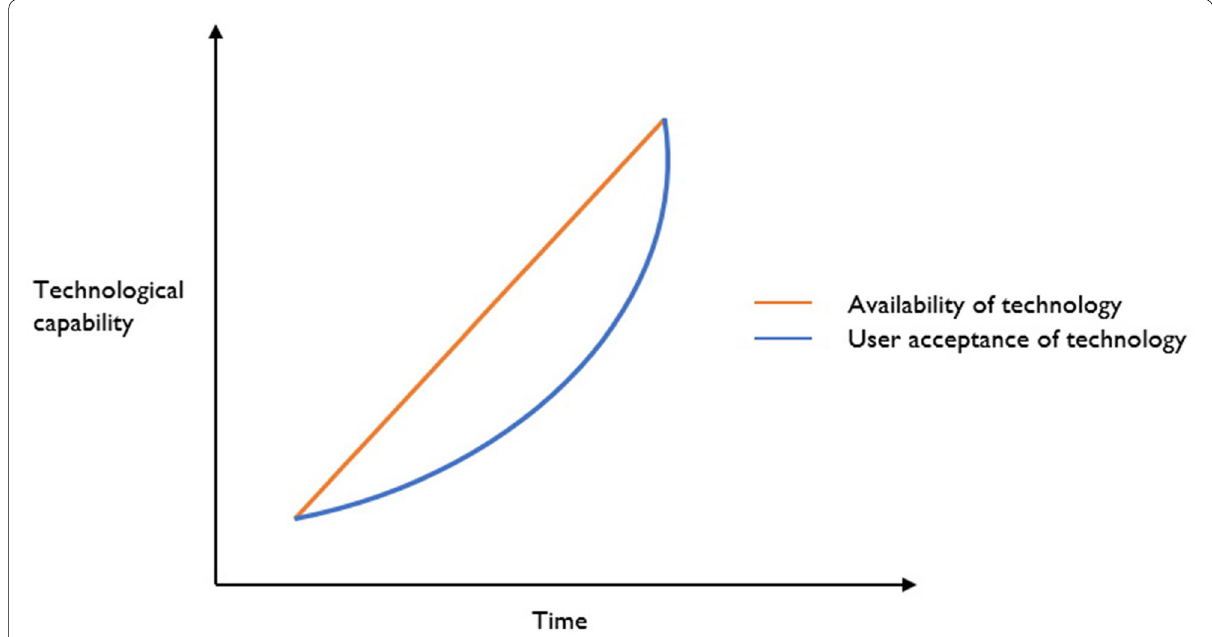
Fig. 4 Future states of availability and user acceptance (Source: (Atkins